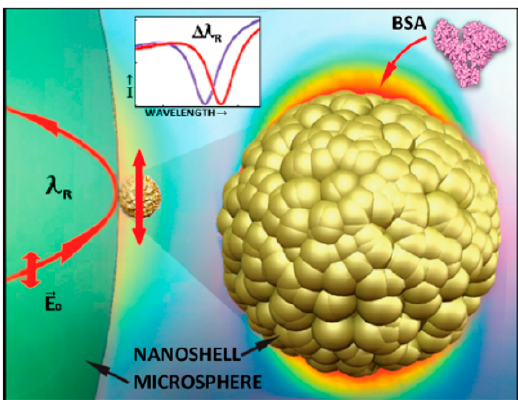
Figure 15. Diagram shows the functionalized surface of a microring resonator. DNA oligomer is immobilized on the surface. Telomerase extracted from a cancer cell is introduced into the system along with dNTPs. The result shows that the system can detect telomerase activity. Reprinted with permission from [38].